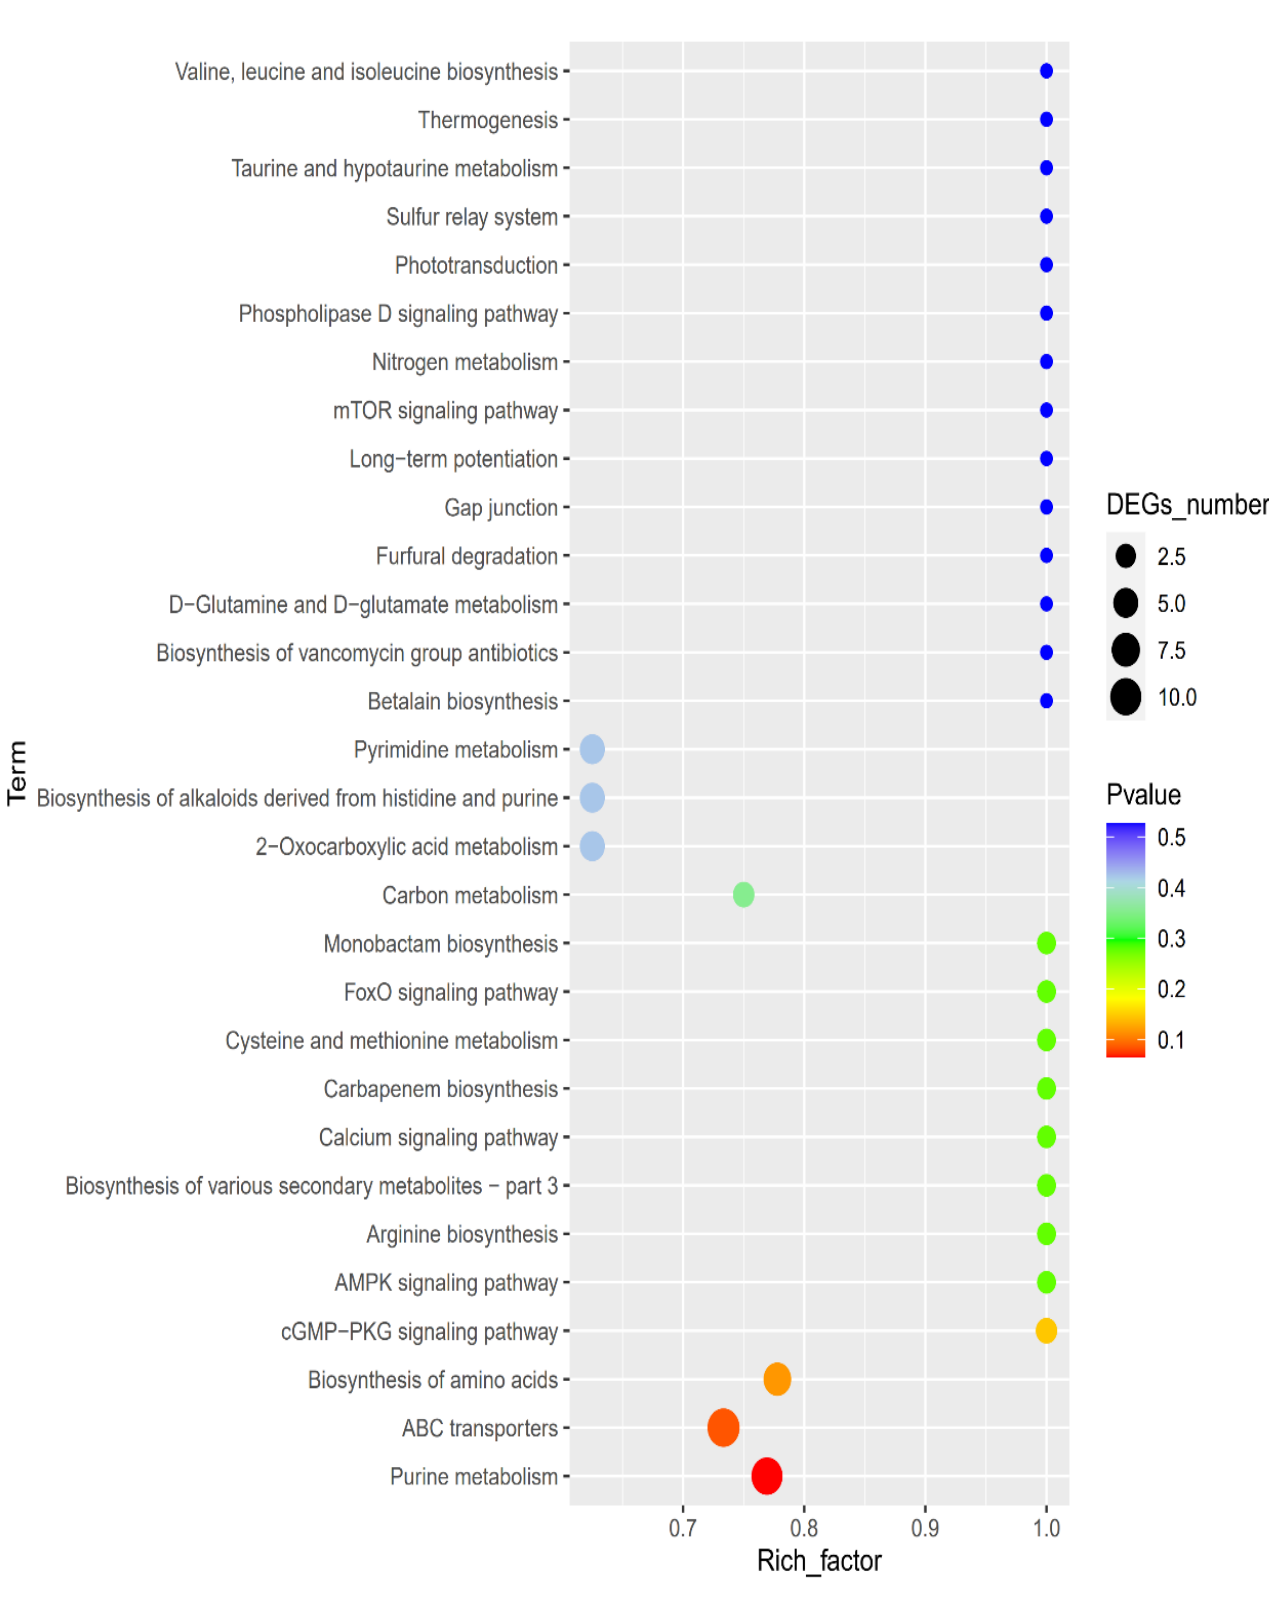
Figure 8. Heat map of differential metabolites cluster. Each row represents one differential metabo- lite identified. The color represents the metabolite abundance, the red areas in the heat map repre- sent the higher content of metabolites, and the blue areas are the lower concentrations. CK and T refer to DIW and PALA (0.2%) treatment, respectively.